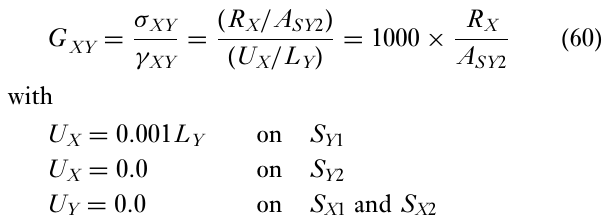
= X , and a constraint, X1 X2